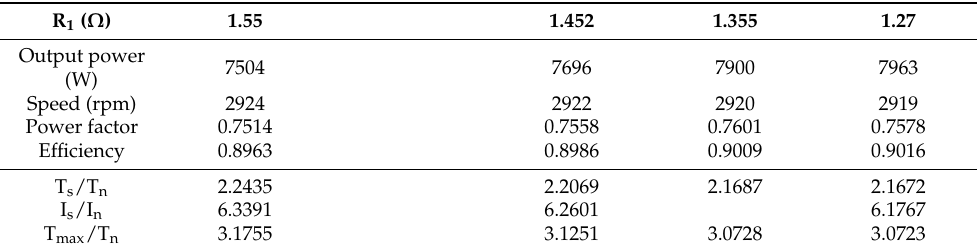
Table 5. Nominal, start, and maximum torque results on the 7.5 kW motor (equal heating criteria, variations of R 1 ).